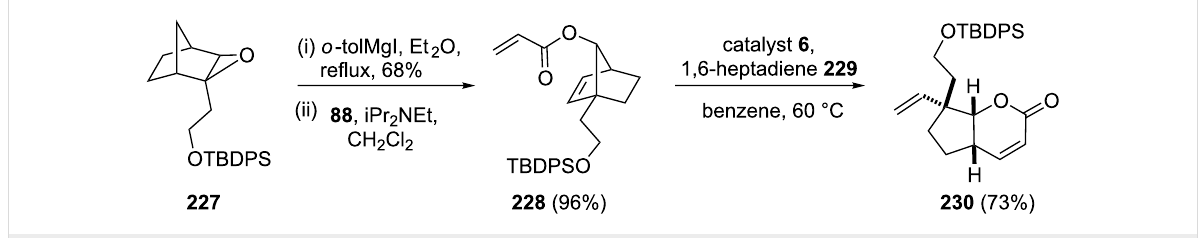
Scheme 46: RRM protocol towards the synthesis of bicyclic lactone 230 .